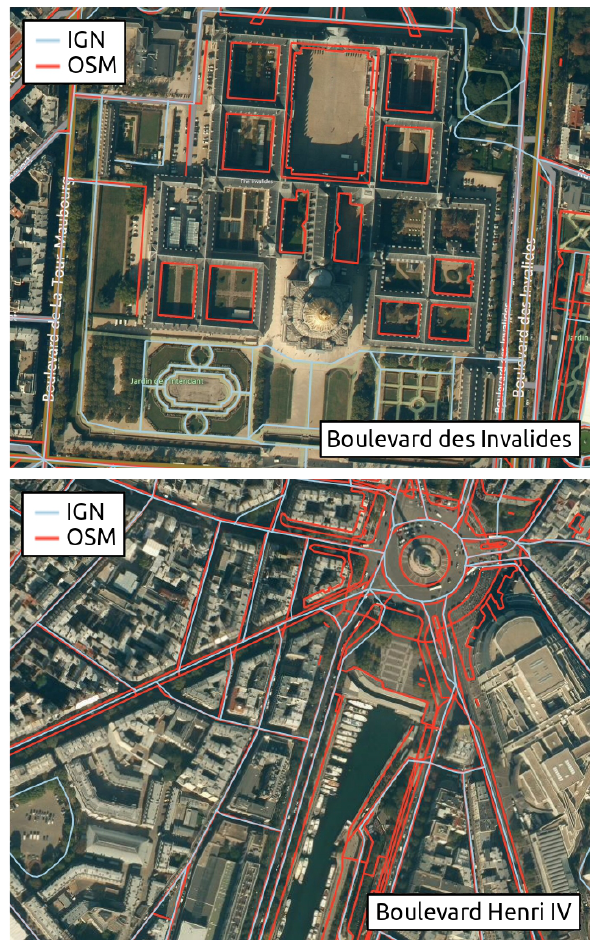
Figure 2. Examples of areas where OSM dataset shows more pedestrian pathways than IGN dataset (top) and multiple line entities for the same IGN road (bottom) (basemap: © Bing Maps; data: © IGN and © OpenStreetMap contributors)